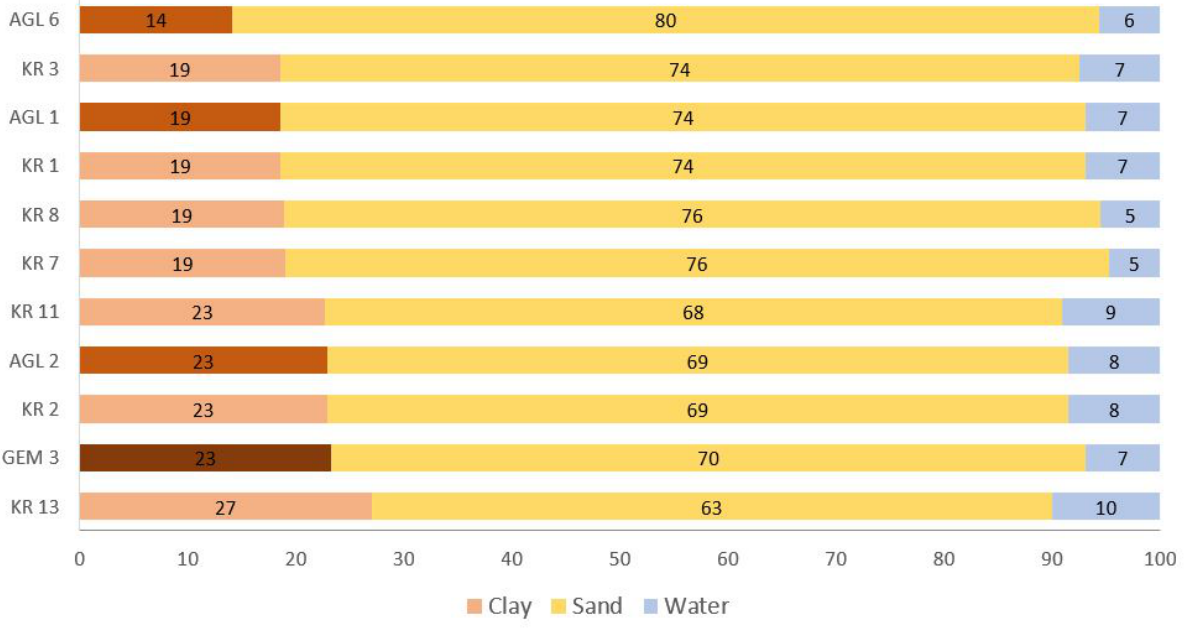
Figure 3. Prescription of used specimens – graph shows percent procuration of clay, sand and water in the mixture. Mixture